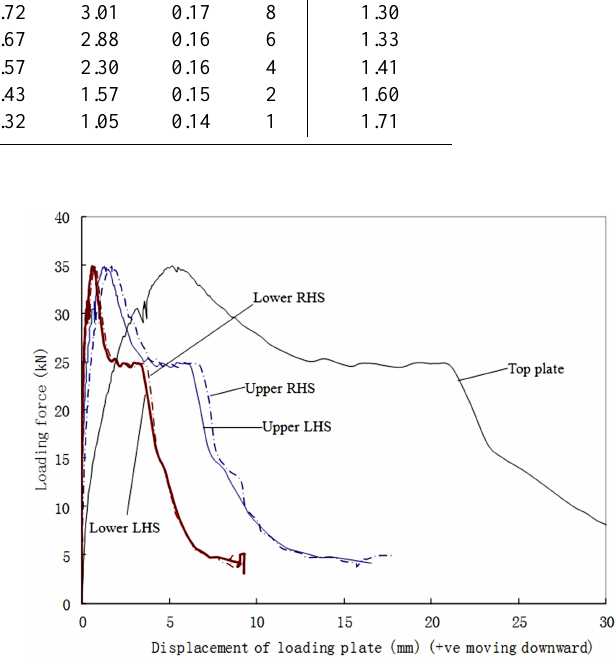
Figure 8. Loading force against the displacement of slope surface.